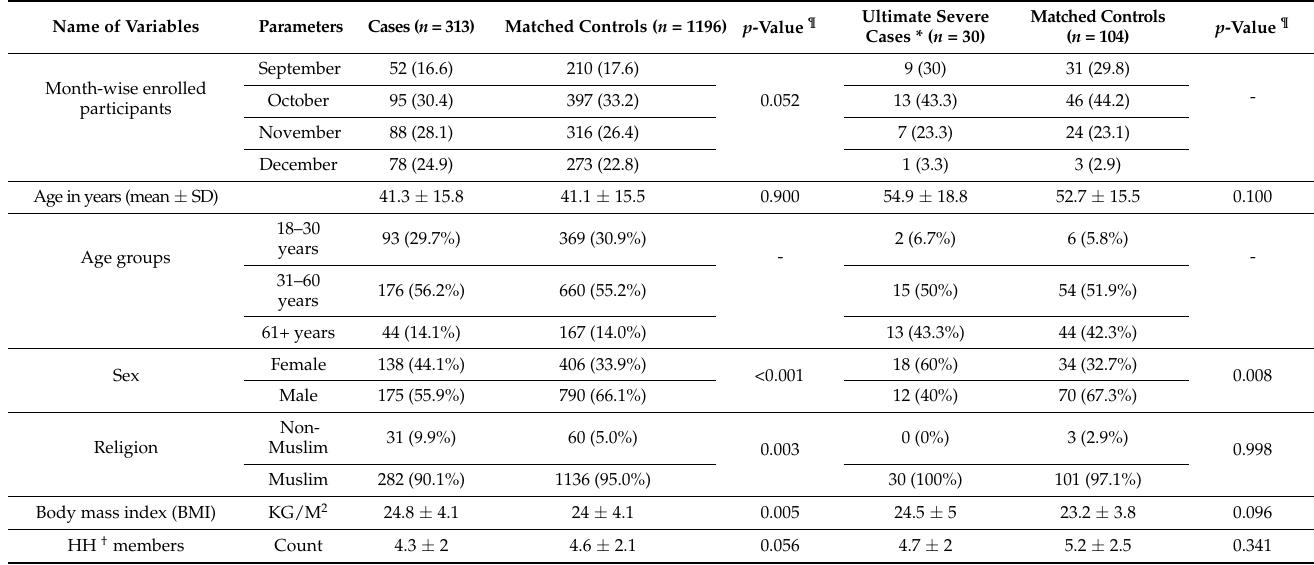
Table 1. Comparability of cases and